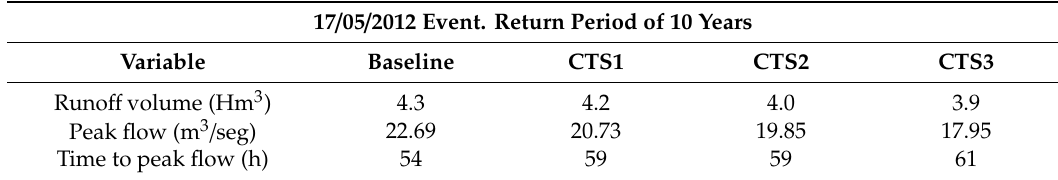
Figure 17. The hydrographs for the studied scenarios as modeled with CTSS8. Baseline scenario (blue), CTS1 scenario (yellow), CTS2 scenario (green), and CTS3 scenario (red). Table 7. Comparison of the proposed scenarios as modelled with CTSS8.